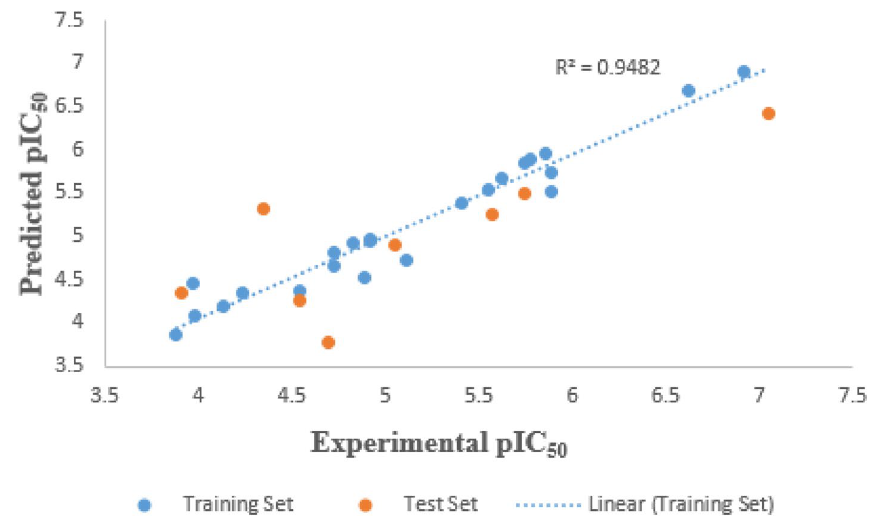
Fig. 1 Experimental activity plotted against predicated activity for training and tests sets of the